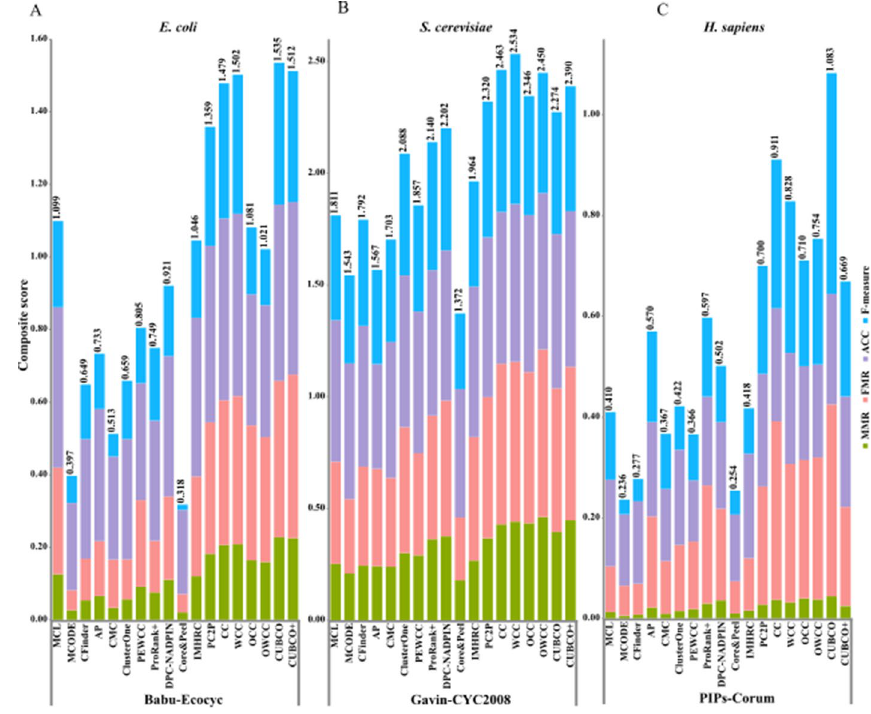
Fig. 1 Comparative analysis of predicted protein complexes from different approaches across PPI networks of different organisms. PPI networks of A E. coli , B S. cerevisiae , and C H. sapiens are considered. The comparative analyses are based on a composite score that is a sum of ACC, F-measure, FRM, and MMR (see Evaluation metrics). Eighteen approaches are compared on three combinations of PPI networks and the gold standard. CUBCO performs on par with the other best-performing approaches that model a protein + complex as biclique spanned subgraph, PC2P, GCC-v (CC, WCC, OCC, and OWCC), and outperforms all other approaches based on the composite